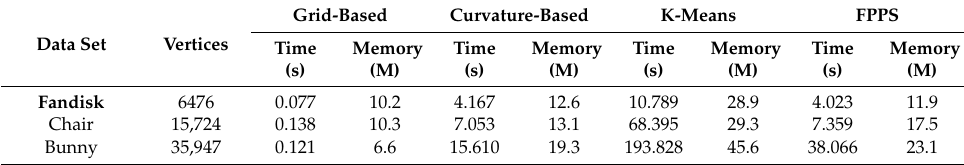
Table 6. The running time and memory usage of the simplification